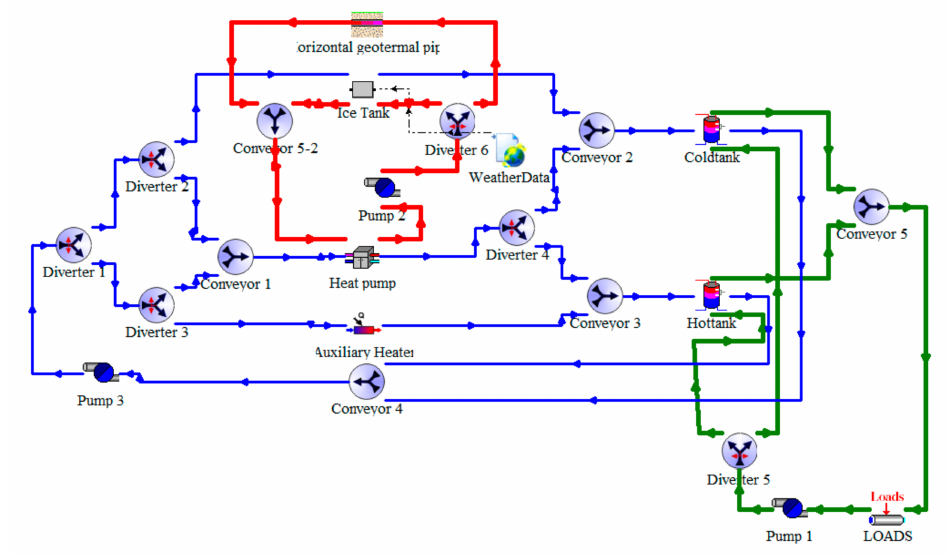
Figure 2. Schematic of the Trnsys